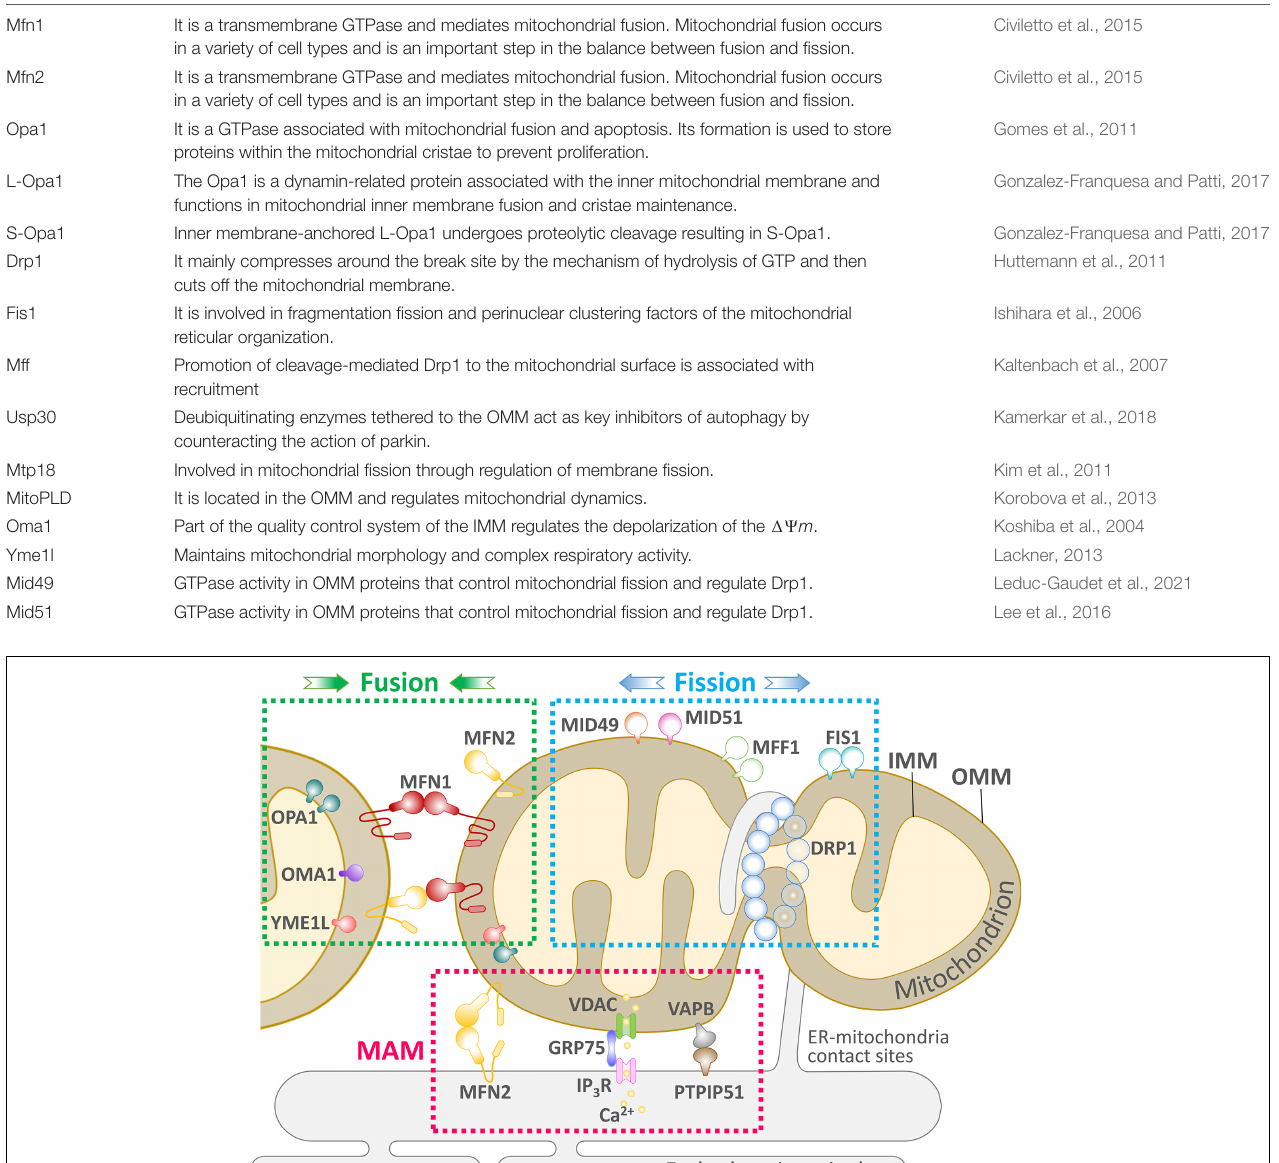
TABLE 1 | Summary of mitochondrial morphological effect proteins. Protein